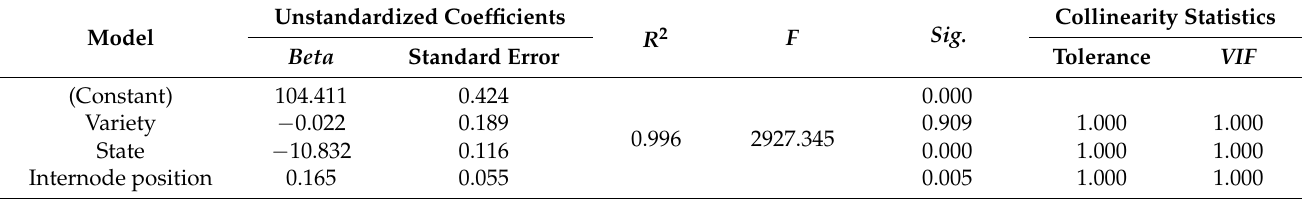
Table 4. Table of regression coefficients of the moisture content of bunch